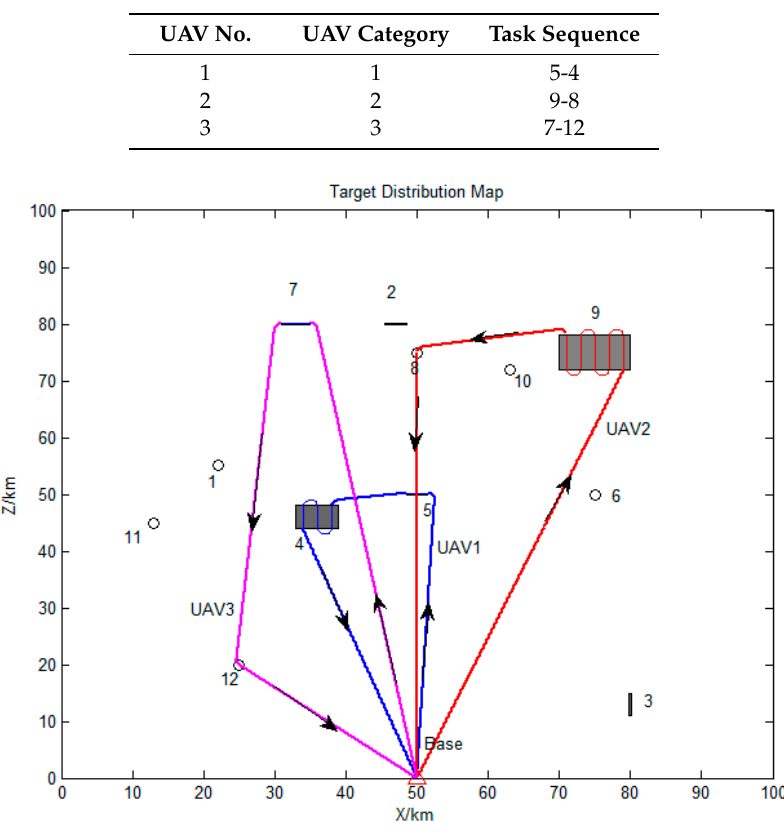
Figure 11. Paths of all UAVs in Scenario 1.